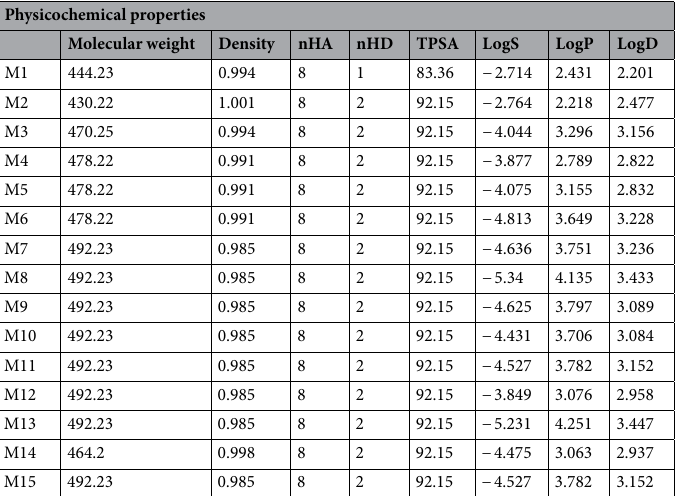
Physicochemical